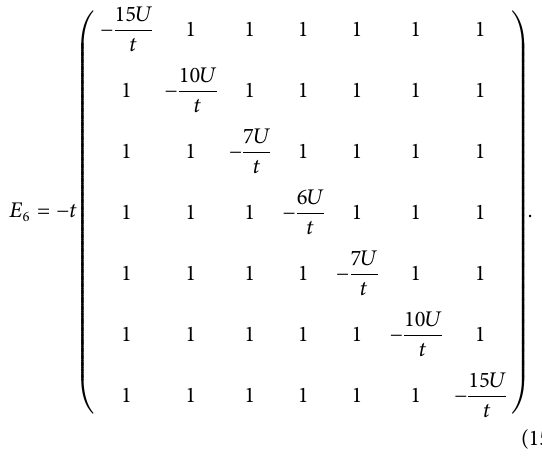
lattice point α , it can be exchanged with another lattice point α ′ , which becomes entangled with the particle qubits through the exchange gate and corrects the error. In the space of N-qubits, a single-bit quantum measurement will appear at each lattice point when the evolution of the particles is in the discrete time quantum walk. The measurement operator is: